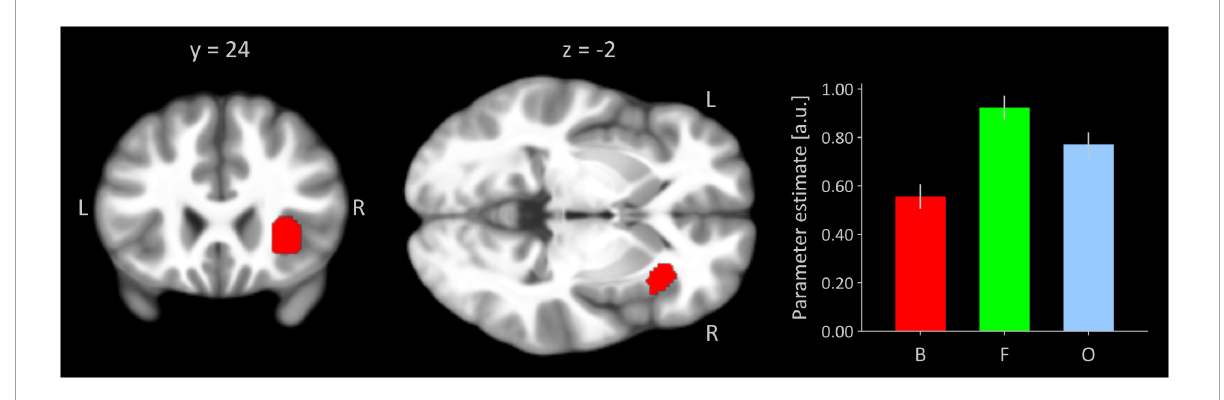
FIGURE1 Right anterior insular seed region functionally defined by invU-shaped activation effect at a significance level of p < 0.05, whole-brain FWE-corrected. Cluster is overlaid on coronal and transversal sections obtained from participants’ MNI-normalized and averaged T1 images ( N = 41) using MRIcroGL (Rorden and Brett, 2000). L, left; R, right. The bar graph depicts cluster-averaged estimated neural activation for conditions of boredom (B), flow (F), and overload (O); the error bar is the standard error of mean ( N = 41).